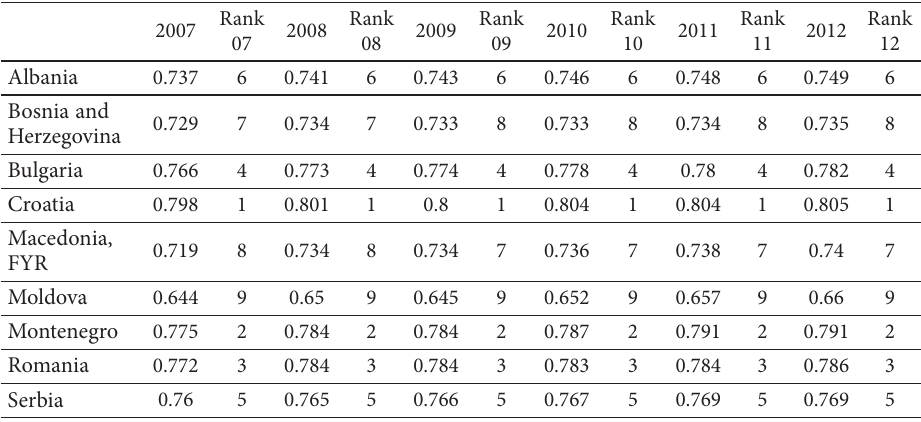
Table 2. HDI and ranking of the selected Southeast European countries,